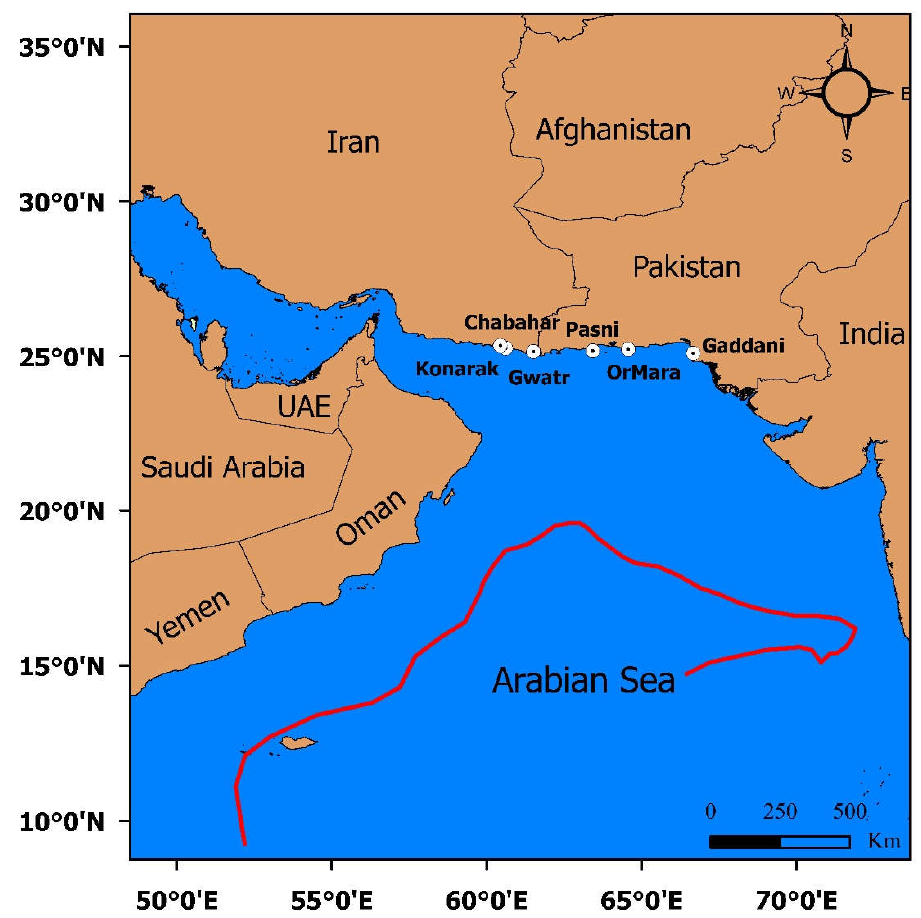
Figure 1. Tropical cyclone Kyarr track in the Arabian Sea (2019).